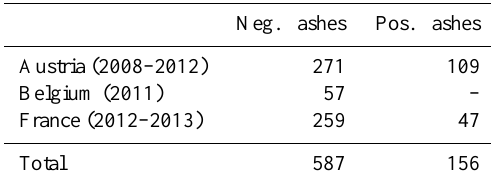
Table 1. Total number of flashes recorded with the VFRS. Neg. flashes